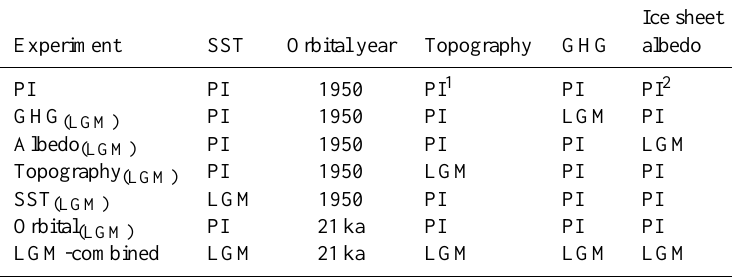
Table 1. Summary of experiments and boundary conditions. Ice sheet Experiment SST Orbital year Topography GHG albedo 1950